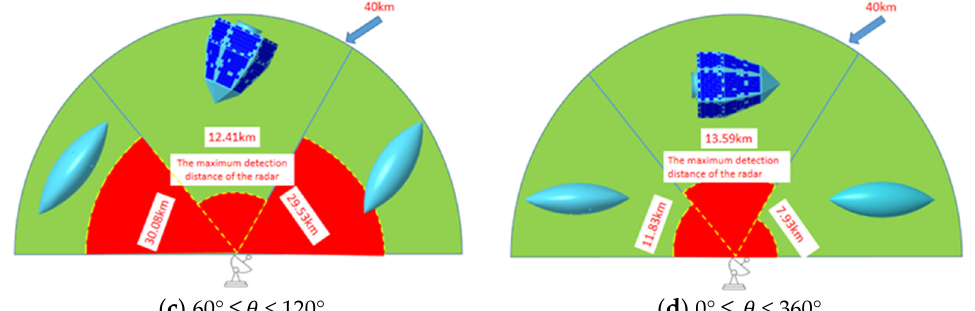
Figure 17. Comparison of the maximum radar detection distances of the three stealth satellites. ( a ) Spaceward; ( b ) Groundward; ( c ) Lateral; ( d ) Omnidirectional.